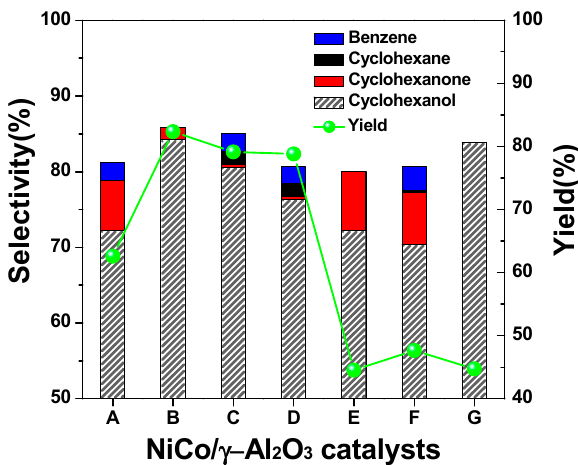
Figure 5. Phenol conversion and product selectivity over different catalysts: ( A ) Ni/ γ -Al 2 O 3 , ( B ) Ni-3Co/ γ -Al 2 O 3 , ( C ) Ni-1.5Co/ γ -Al 2 O 3 , ( D ) Ni-1Co/ γ -Al 2 O 3 , ( E ) Ni-0.67Co/ γ -Al 2 O 3 , ( F ) Ni-0.33Co/ γ -Al 2 O 3 , and ( G ) Co/ γ -Al 2 O